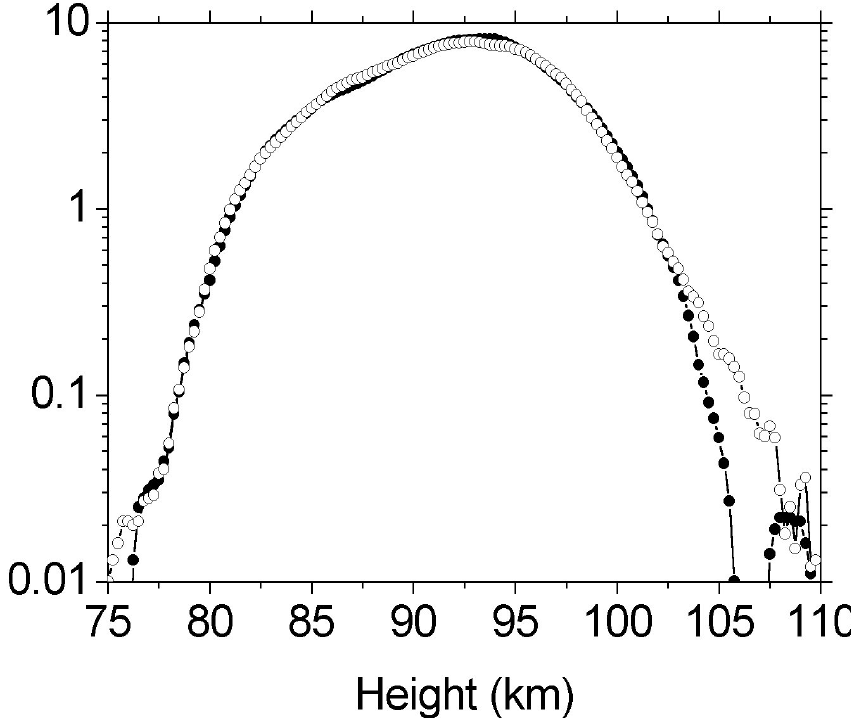
Fig. 15. Average Na profiles for 1972–1986 (closed circles) and 1987–2001 (open circles), respectively, measured at S˜ao Jos´e dos Campos (23 ◦ S) (after Clemesha et al.,